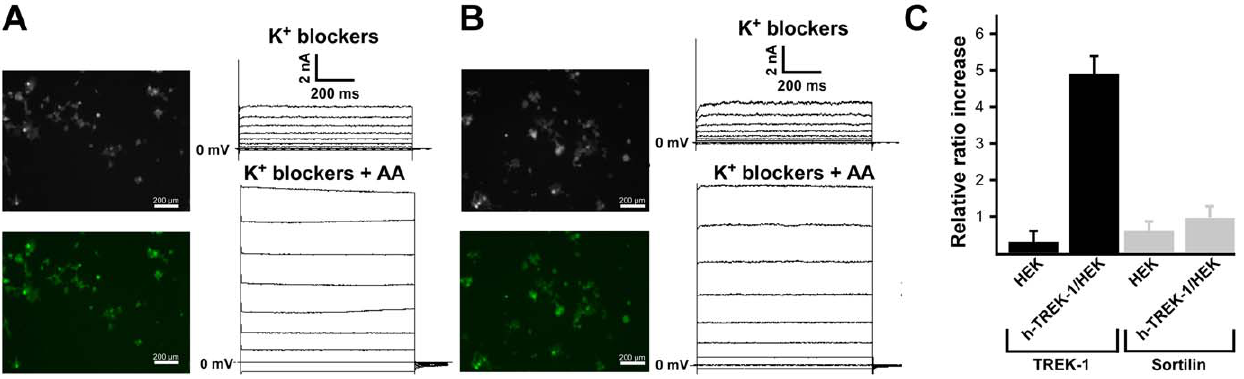
Figure 1. GFP expression and functional h-TREK-1 channel activity on h-TREK-1/HEK cells. A ) Typical pictures of cells observed in transmission and in fluorescence at round three of cell culture. Functional channel activity was evaluated by current activation with 10 m M AA. B ) Typical pictures of cells observed in transmission and in fluorescence at round fourteenth of cell culture. Functional channel activity was evaluated by current activation with 10 m M AA. C ) Real time q-PCR. Levels of TREK-1 or sortlin expression were normalized with the cyclophillin D expression.